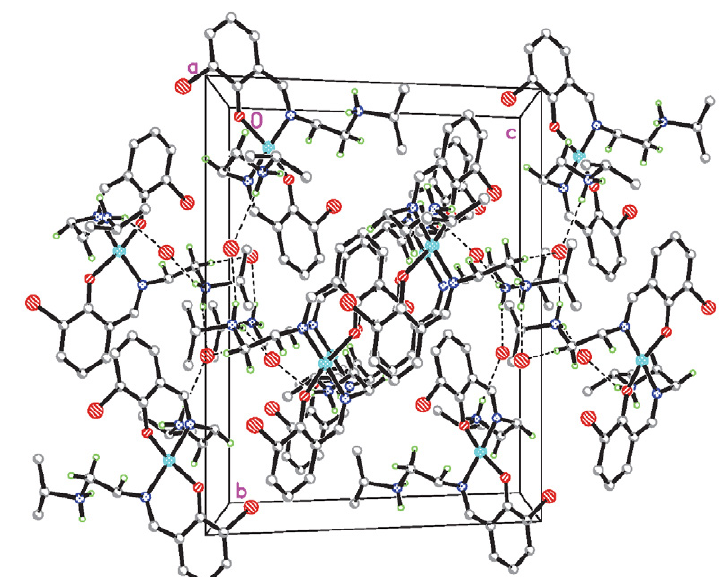
Figure 4. Molecular packing structure of complex 1 , viewed along the a axis. Hydrogen bonds are shown as dashed lines.